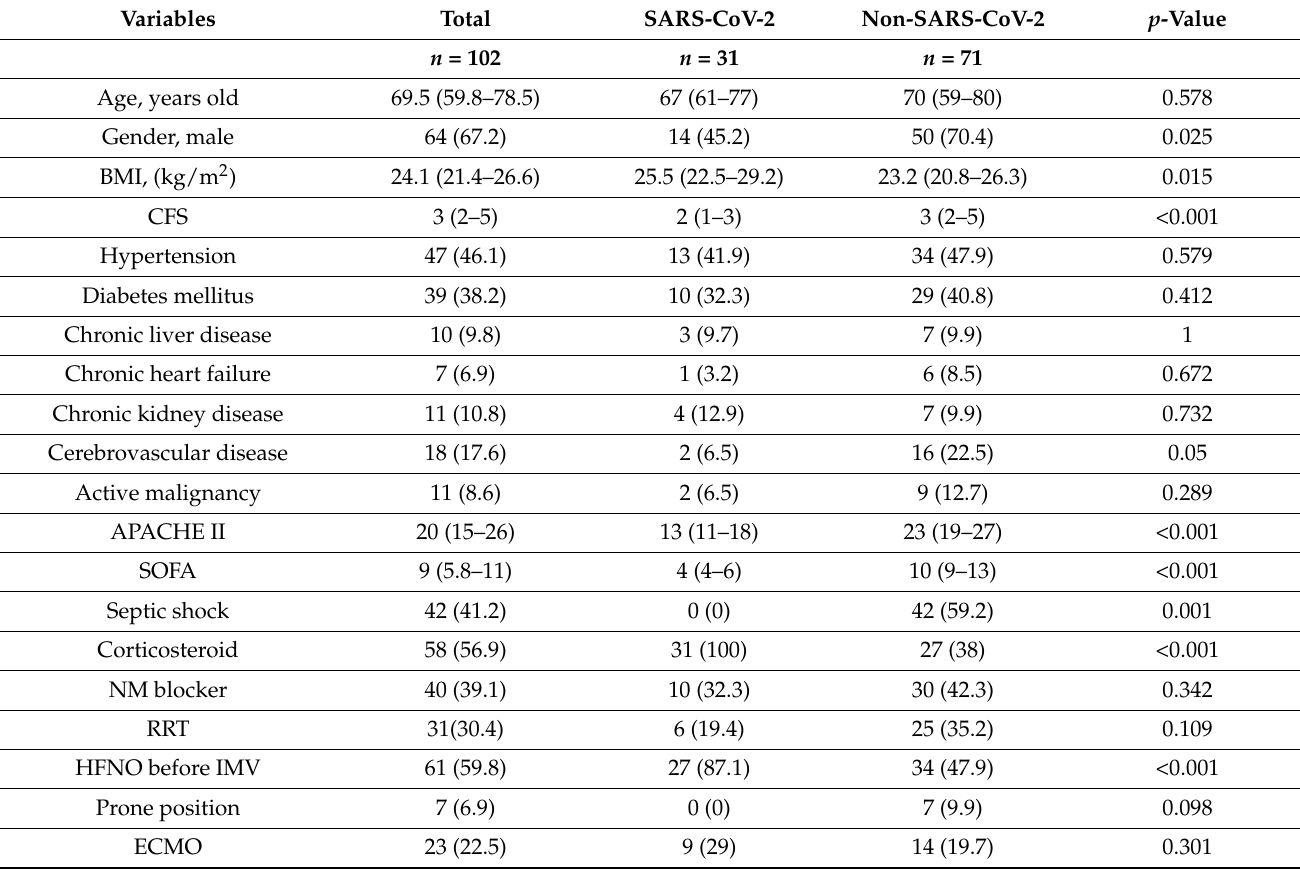
Table 1. Baseline characteristics of total patients, SARS-CoV-2, and non-SARS-CoV-2 -19 respiratory viruses.